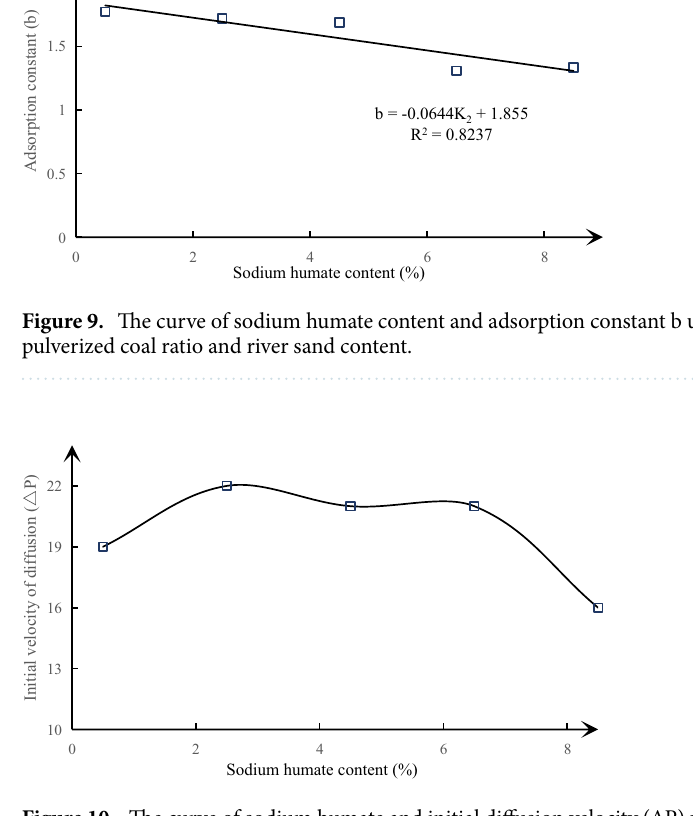
Figure 10. The curve of sodium humate and initial diffusion velocity (ΔP) under the condition of fixed pulverized coal ratio and river sand